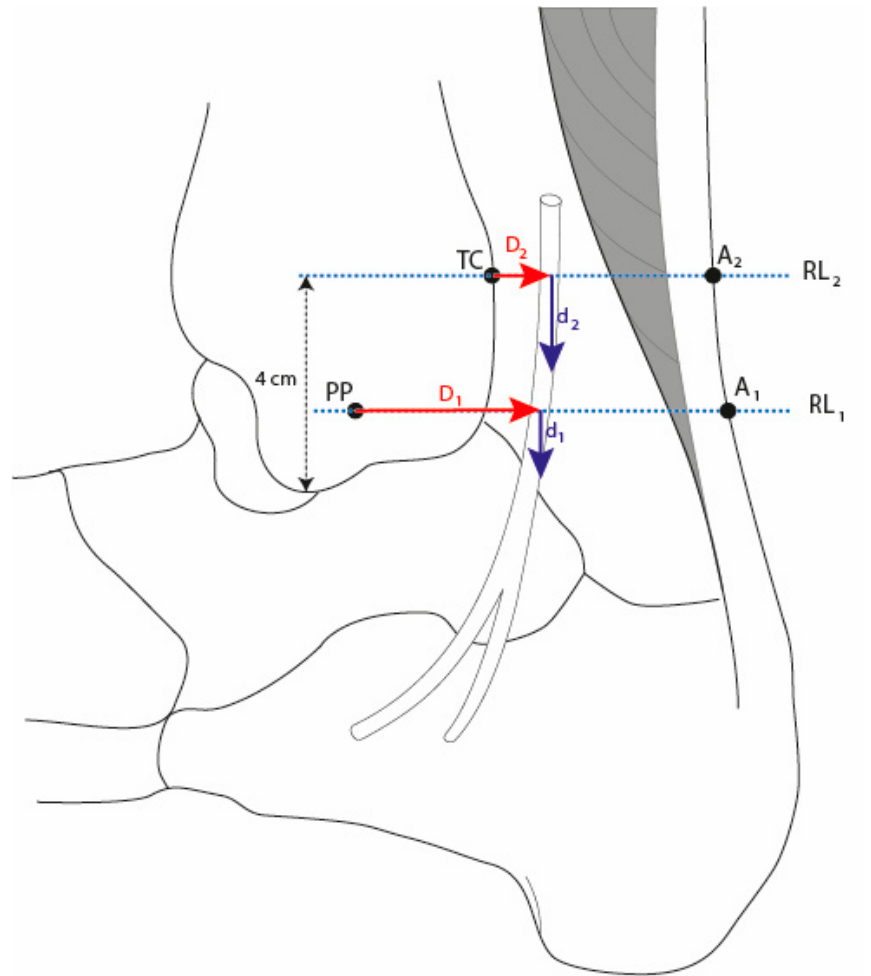
Figure 1. Diagram of the anatomical reference points for the retromalleolar and supramalleolar technique. PP = most prominent point of the medial malleolus, A 1 = projection of a straight line from PP to the rear edge of the Achilles tendon, RL 1 = retromalleolar reference line, D 1 = distance from PP, TC = medial edge of the tibial cortex 4 cm proximally from the lower edge of the medial malleolus, A 2